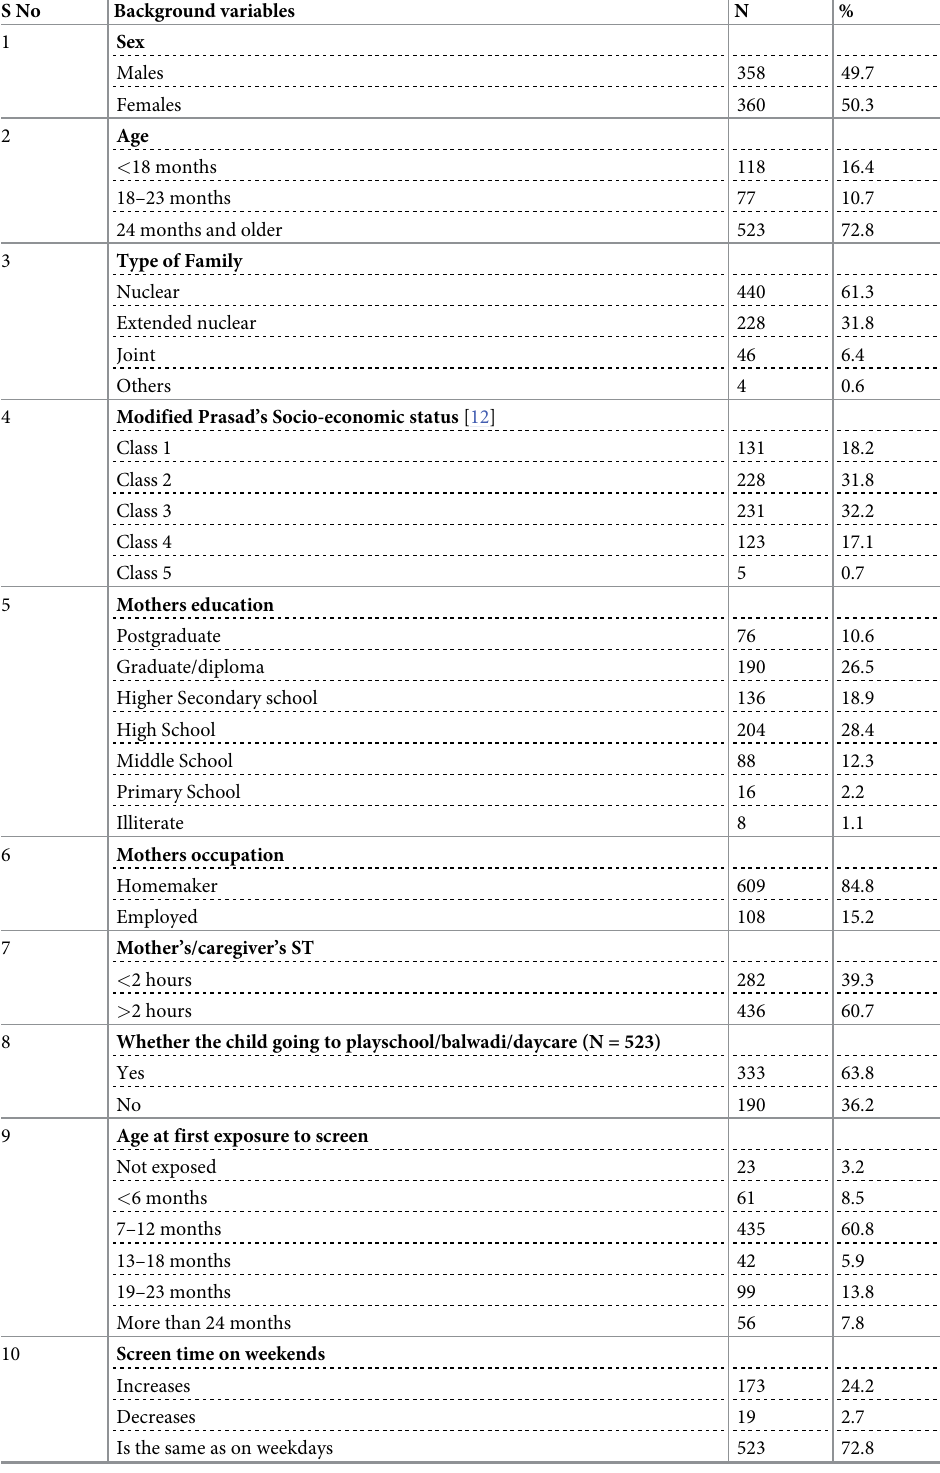
Table 1. Sociodemographic characteristics and screen time details of study